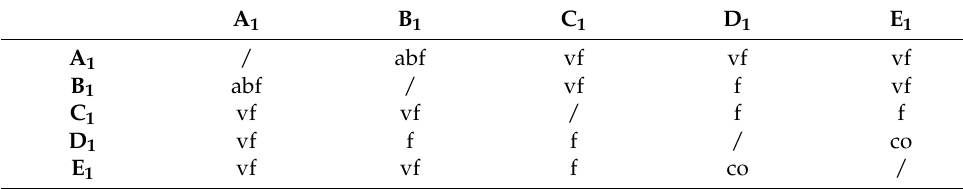
Table 12. Distance relations in the query scene (a) in Figure